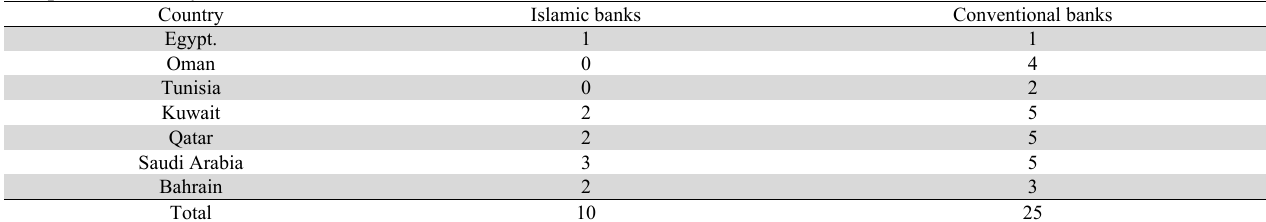
25 Source: designed by the